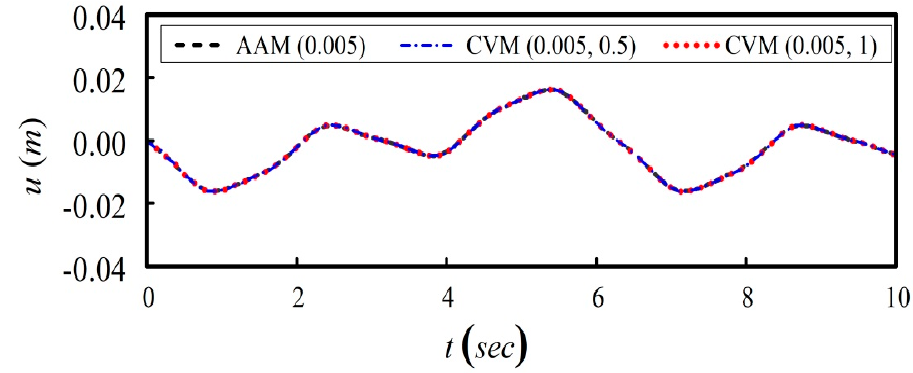
Figure 8. Displacement response for the nonlinear damped SDOF system.